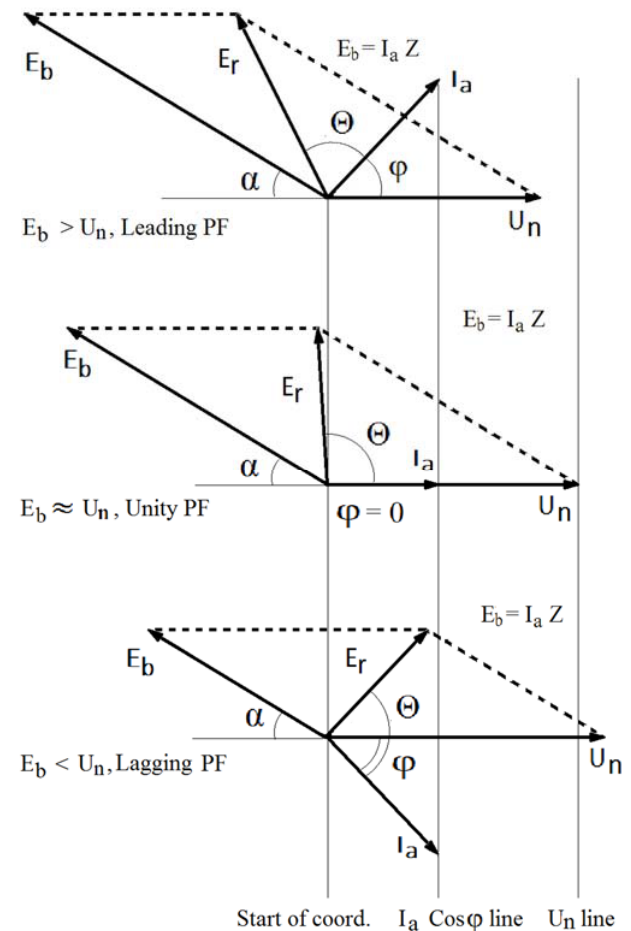
Figure 2. PMSM vector diagrams with different input voltages applied.